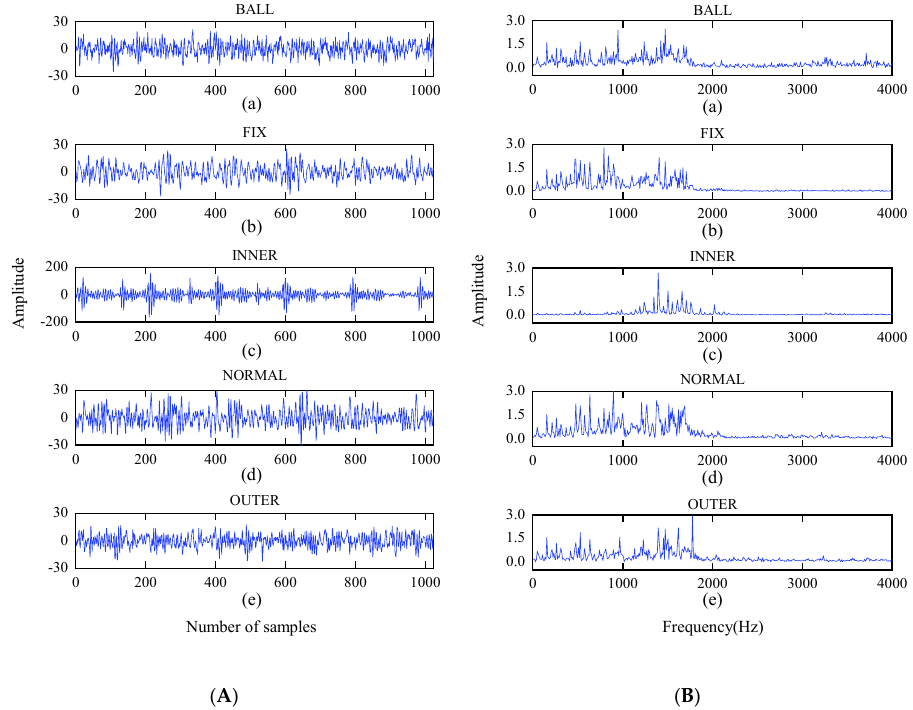
Figure 10. Time domain and frequency domain diagram of test bearing: ( a ) time-domain waveform; ( b ) frequency-domain waveform.